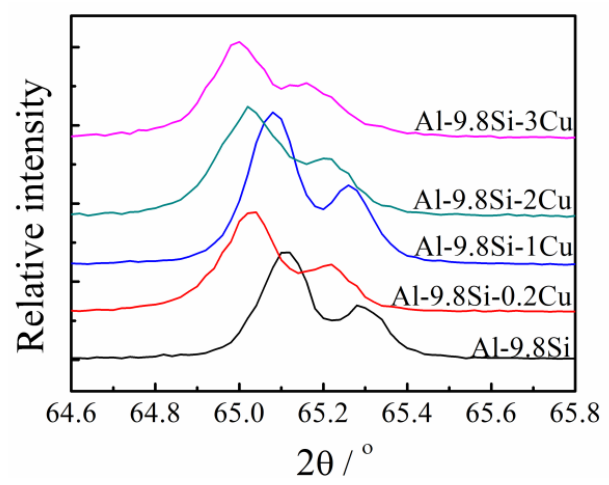
Figure 6. X-ray diffraction spectra of the Al-Si-Cu alloys with different Cu content.